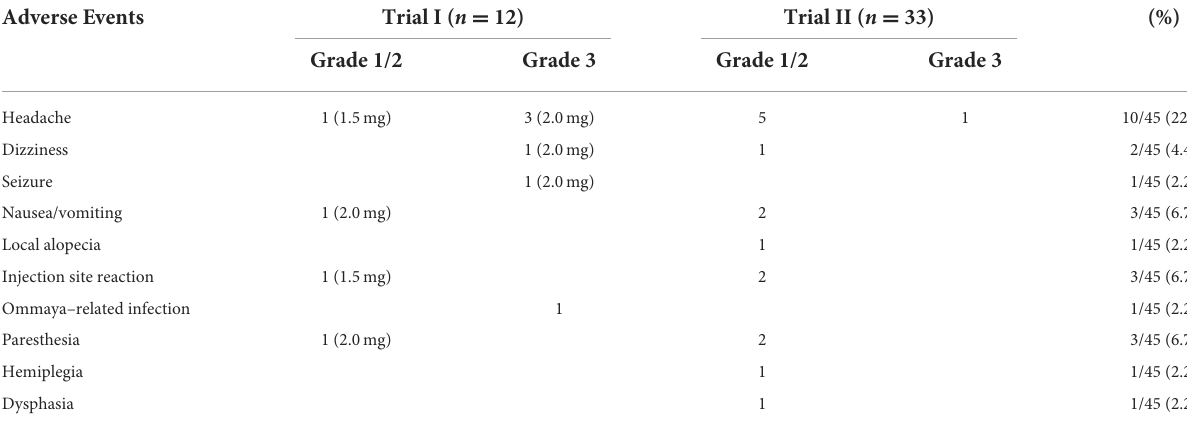
TABLE 3 Acute toxicity in trial I and II study with ATO.